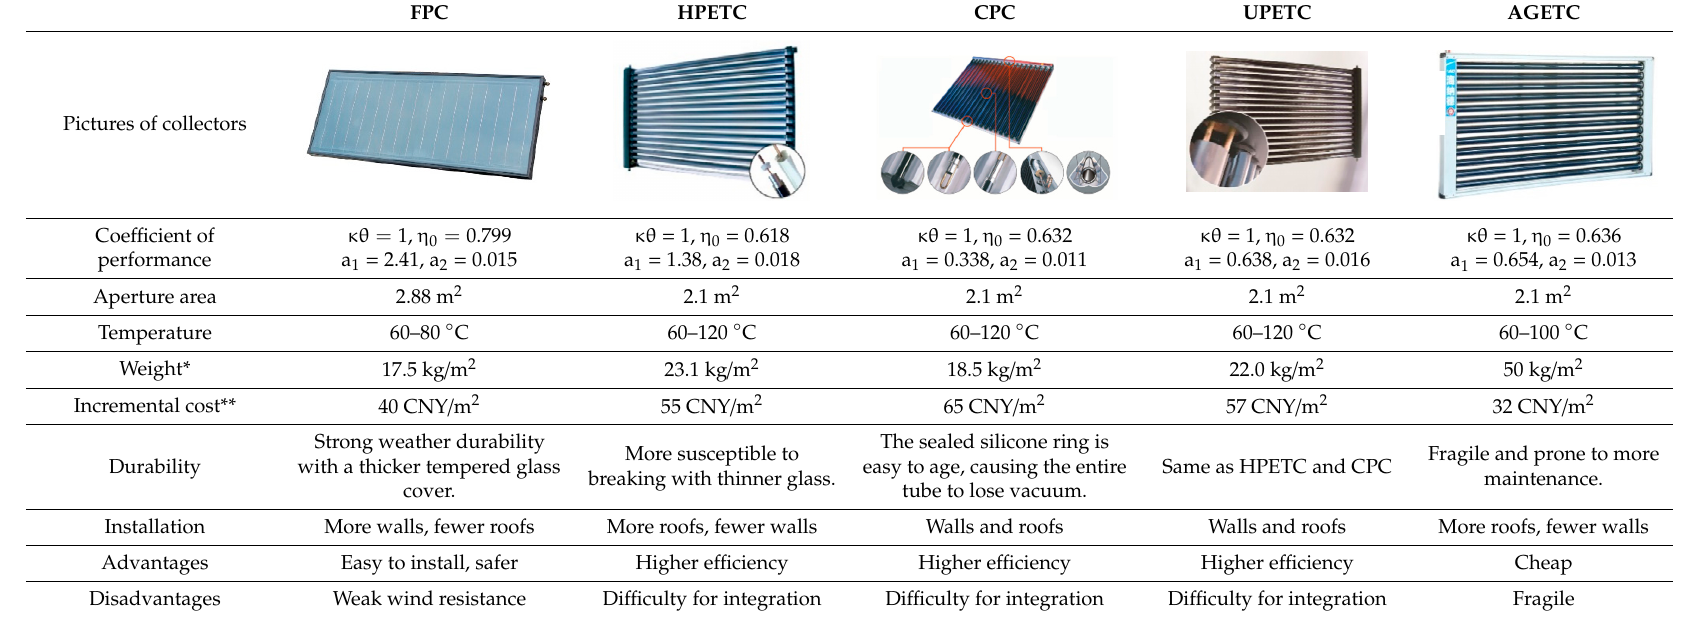
Table 3. A technical and economic comparison of solar collectors commonly used in high-rise buildings.